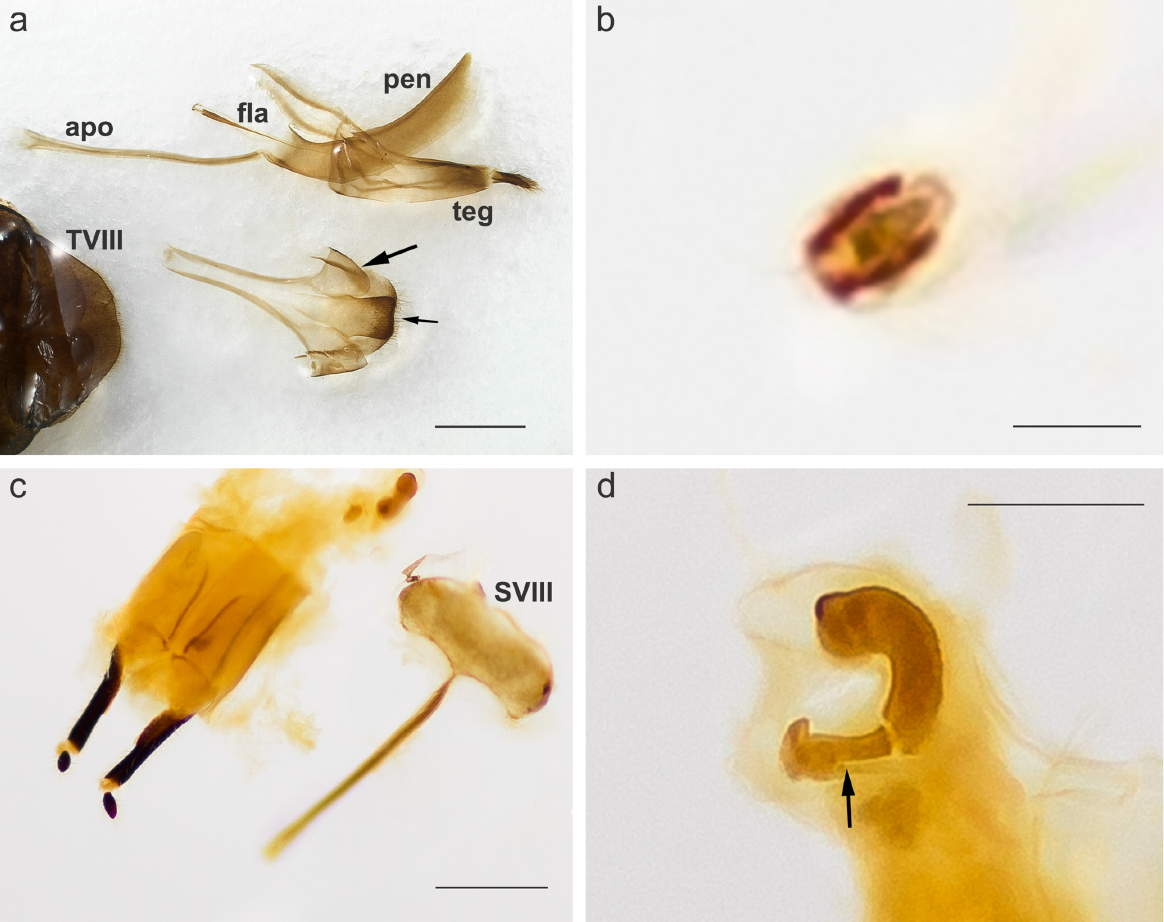
Figure 5. Erotylina leoparda (Lacordaire, 1842), male (a–b) and female (c–d) terminalia. a. apophyses (apo), flagellum (fla), penis (pen), tegmen (teg), tergite VIII (TVIII), big arrow showing outer anterior contours of laterotergite IX, small arrow showing posterior edge of sternite IX. b. Head of penile flagellum. c. Female genitalia and sternite VIII (SVIII). d. Spermatheca, arrow showing distal portion of spermathecal duct. Scale bars: a, c = 1 mm; b = 0.1 mm; d = 0.5